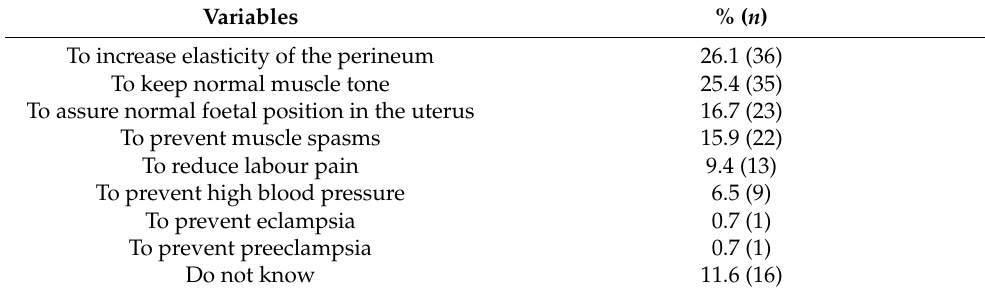
Table 4. Distribution of answers regarding the importance of and information on exercise